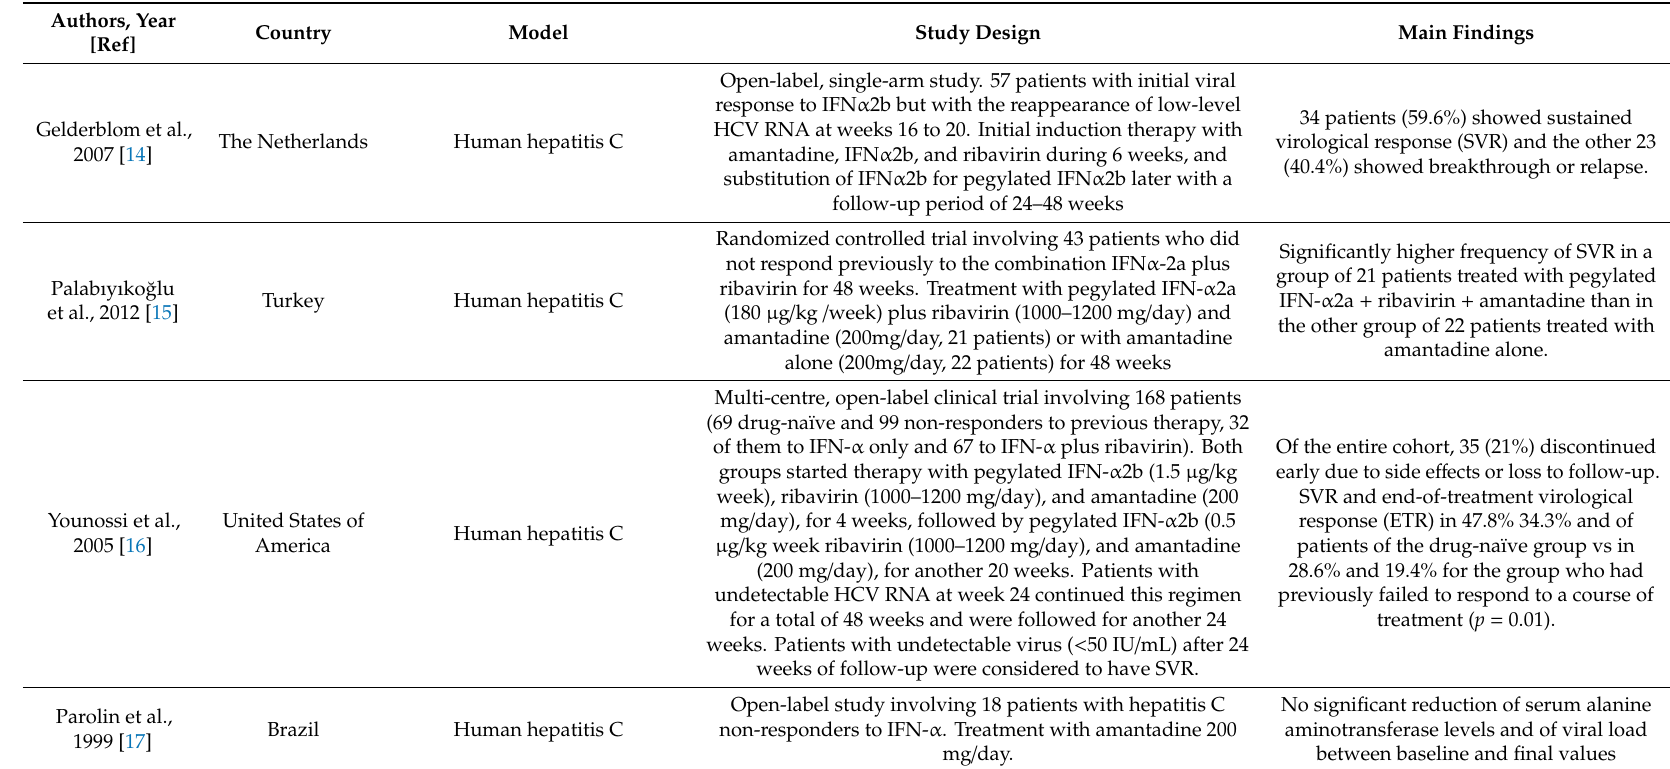
Table 1. Studies assessing the anti-inflammatory e ff ects of